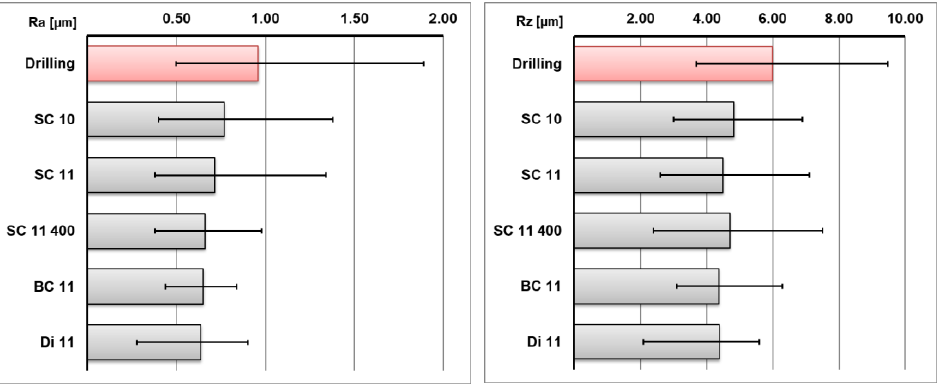
Figure 5. Ra [µm] and Rz [µm] roughness values after drilling and after finishing Inconel 718.